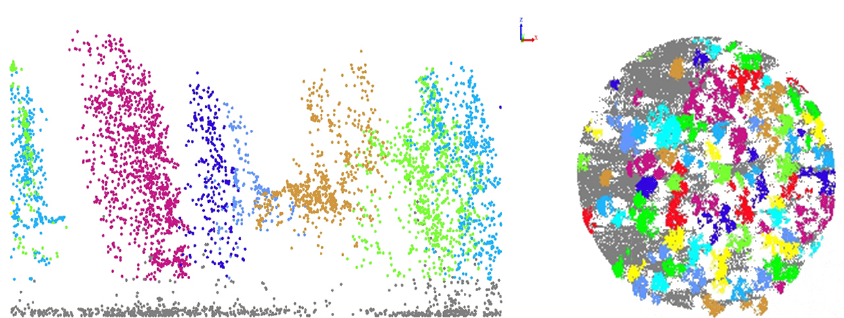
Figure 4. Illustration of point cloud data blocking (front view and top view). In the left figure, to illustrate the missing point clouds due to angular effects, each color represents an individual tree. In the right figure, the missing point clouds in the left figure are shown as white gaps from a different